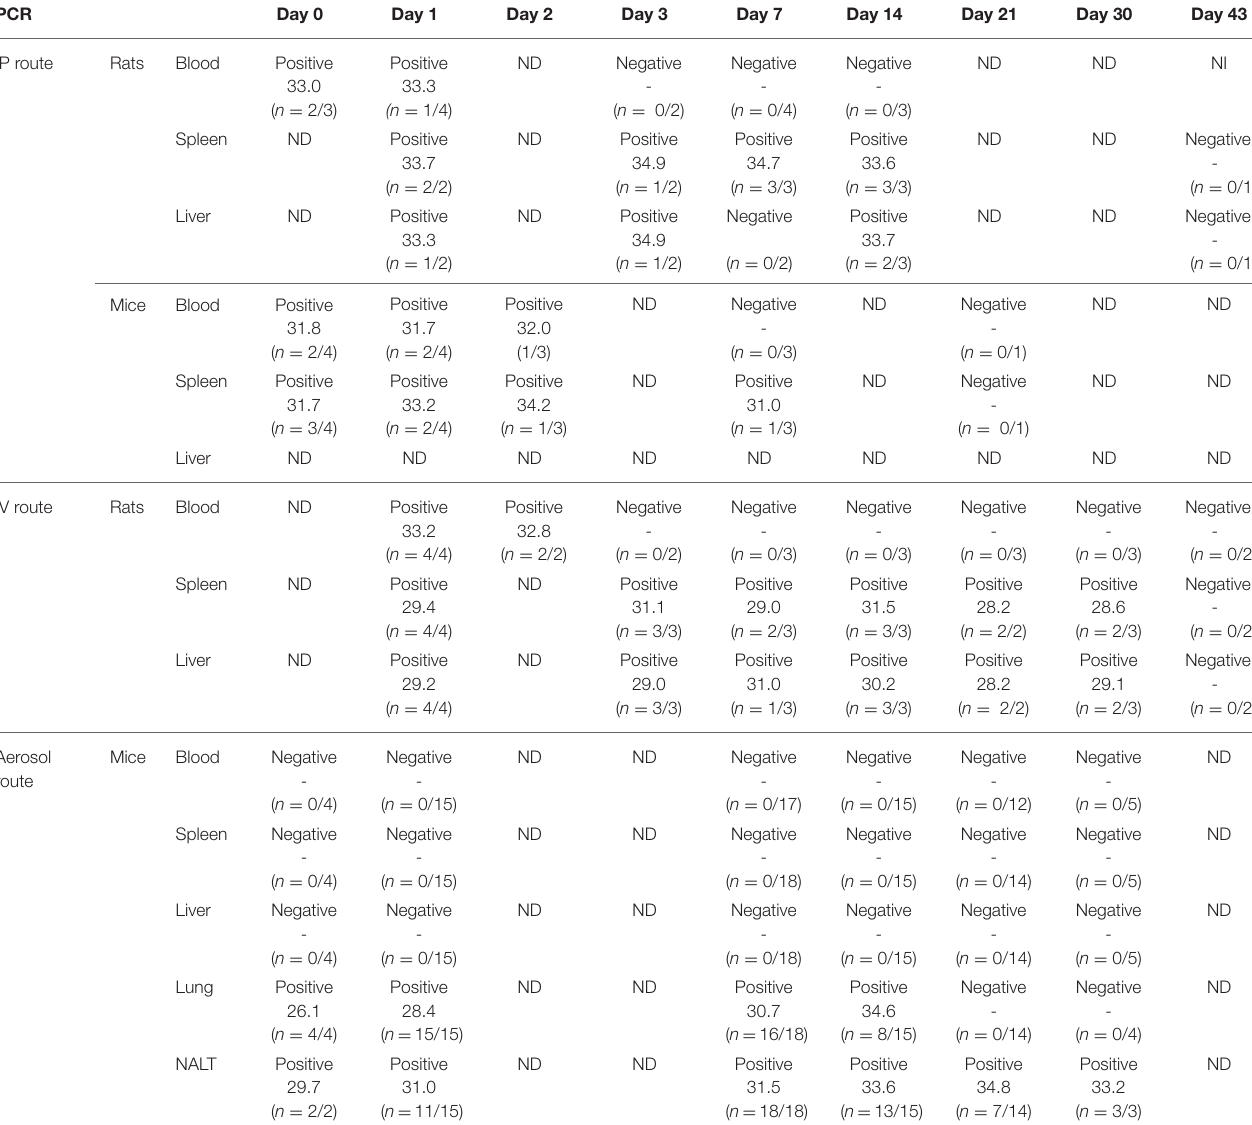
TABLE 1 | Summary of results obtained by qPCR of blood and organs of rats and mice inoculated with Marseillevirus.